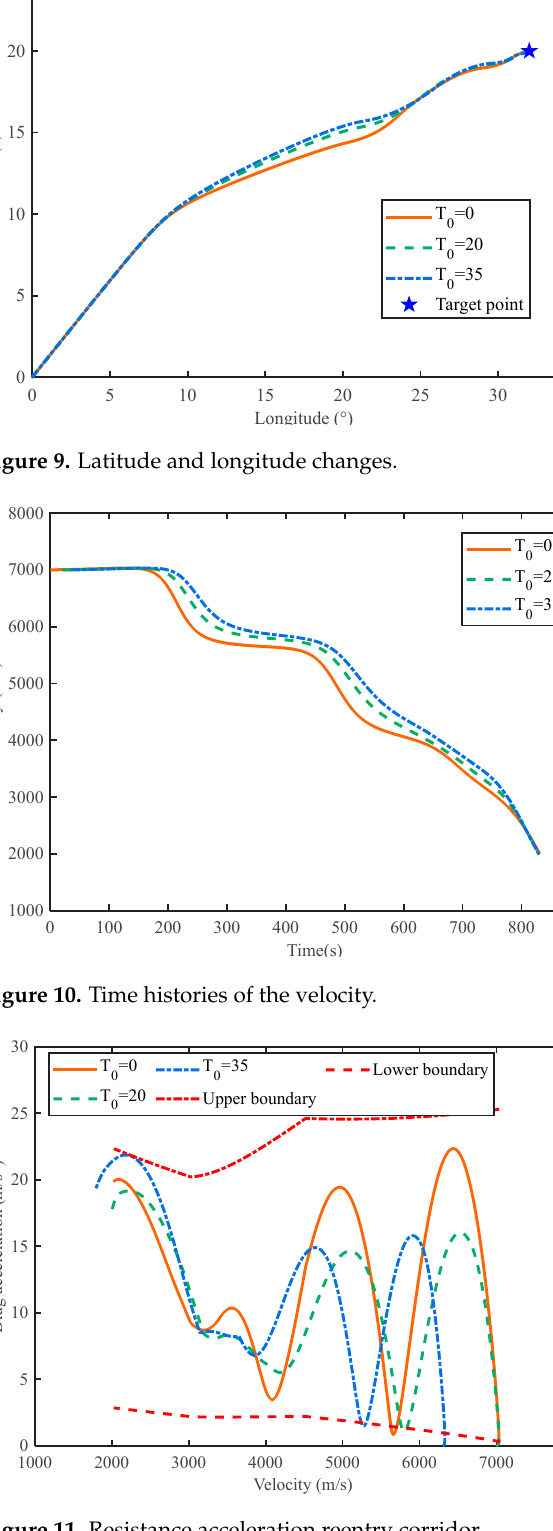
Figure 11. Resistance acceleration reentry corridor.